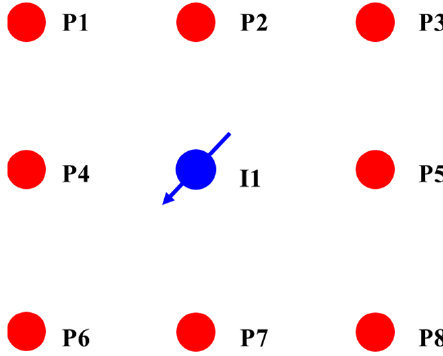
Figure 11. Well location of pilot test well group.